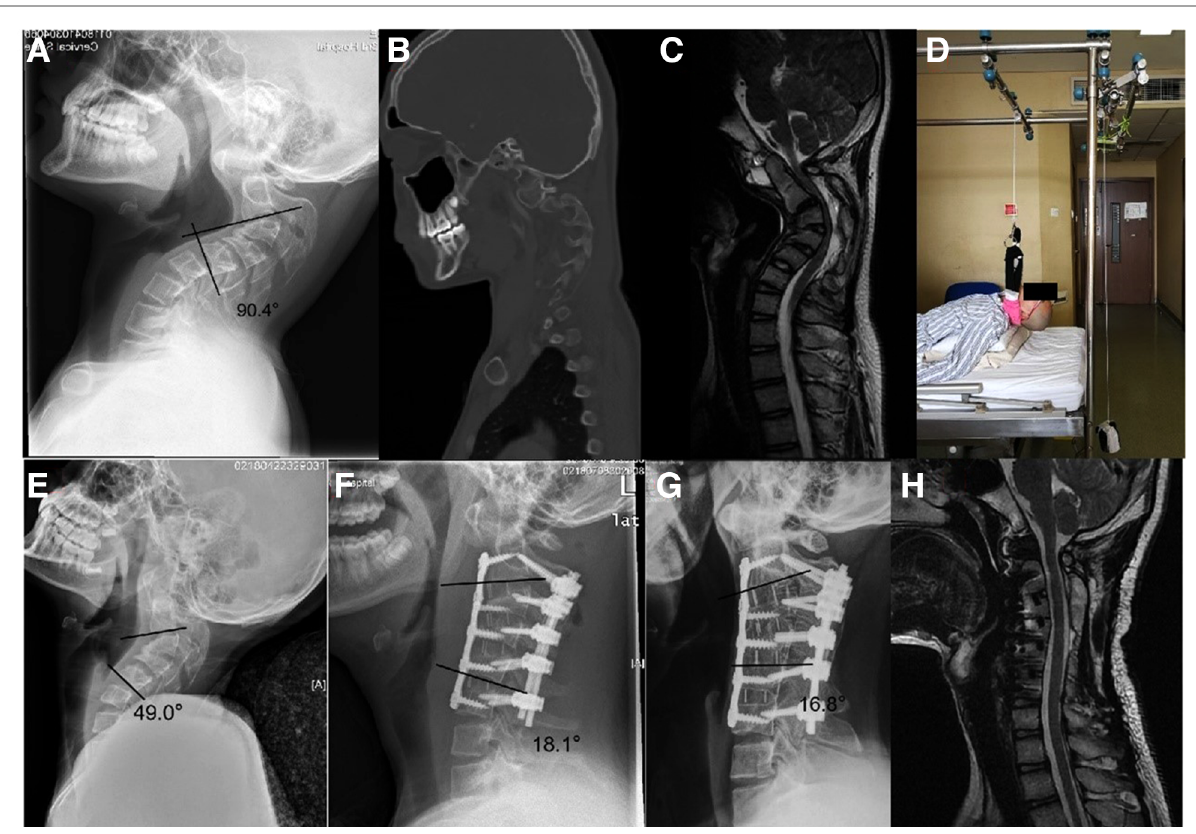
FIGURE 2 Case 2. This 14-year-old male complained of neck pain and weakness of the hands due to myelopathy caused by idiopathic cervical kyphotic deformity. ( A ) Pre-operative x-ray revealed a C2 – 5 Cobb angle of 90.4° before traction. ( B ) A para-sagittal computed tomography (CT) reconstruction showed C3 – 4 facet joint fusion. ( C ) Sagittal magnetic resonance imaging (MRI) showed severe compression of spinal cord at C2 – 4 level. ( D ) One week suspensory traction. ( E ) After one week of suspensory traction, the Cobb angle had reduced to 49°; the correction rate was 45.8%. ( F ) Post-operative x-ray showed the Cobb angle reduced to 18.1°. ( G ) x-ray at 1 year showed no loss of correction. ( H ) MRI showed completed decompression of cervical spinal cord with the modi fi ed mJOA score improved from 14 to 17